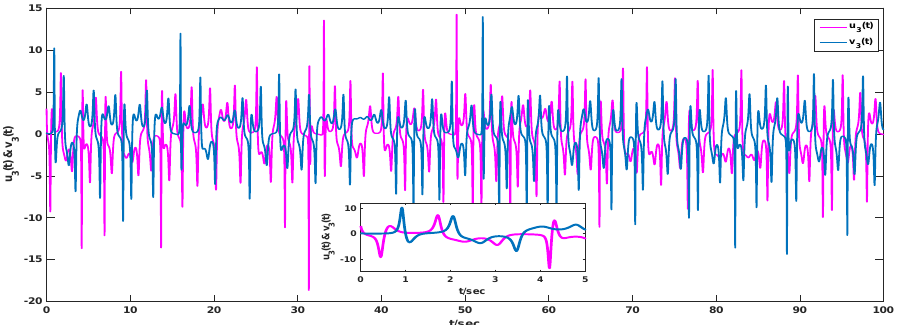
Figure 11. Time response of the states ( t , u 3 ( t )) and ( t , v 3 ( t )) of the drive-response systems (13) and (14) with fractional order q = 0.9.